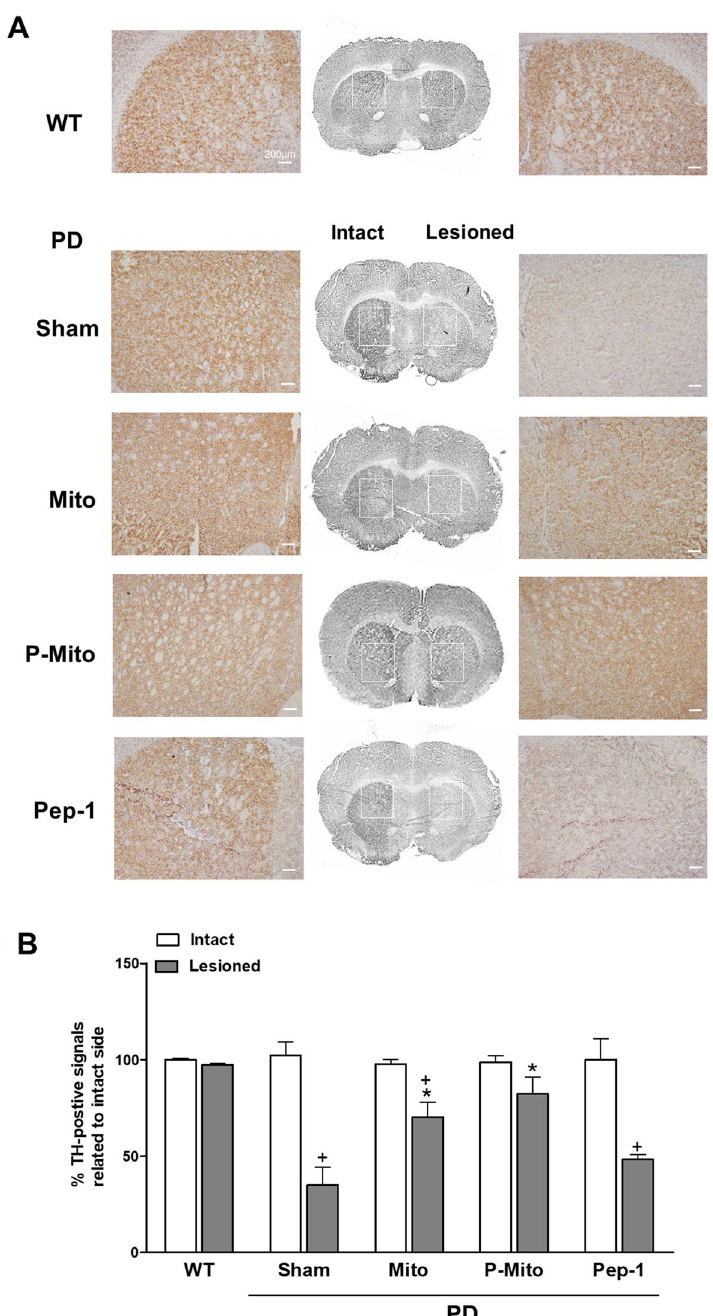
Figure 3. Mitochondrial infusions attenuate unilateral damage in nigrostriatal dopaminergic neurons of Parkison’s disease rats. ( A ) Immunohistologic staining of tyrosine hydroxylase (TH) was performed with coronal forebrain sections. TH expression (brown color) in striata (ST) of the intact and 6-OHDA-lesioned sides, indicated by rectangles, are further shown in high-magnification images in each left or right panel. ( B ) Levels of TH-positive signals in the striatum were evaluated with ImageJ Software and TH expression was quantified by normalizing each image against its contralateral control. + P < 0.05, vs. Intact; * P < 0.05, vs. Sham; WT wild-type controls, PD Parkinson’s disease, Sham vehicle alone, Mito mitochondrial alone, P-Mito Pep-1- labelled